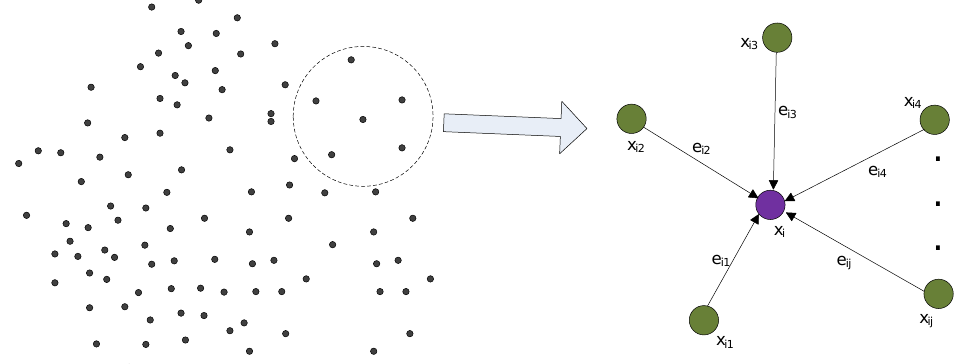
Figure 2. The process of construction of a directed acyclic graph for local feature extraction. On the left is the raw point cloud data, on the right, the graph-like structure extracted from part of the point cloud is represented. x i indicates the central point, e ij are the directed edges connecting center point and its corresponding neighbouring points x ij